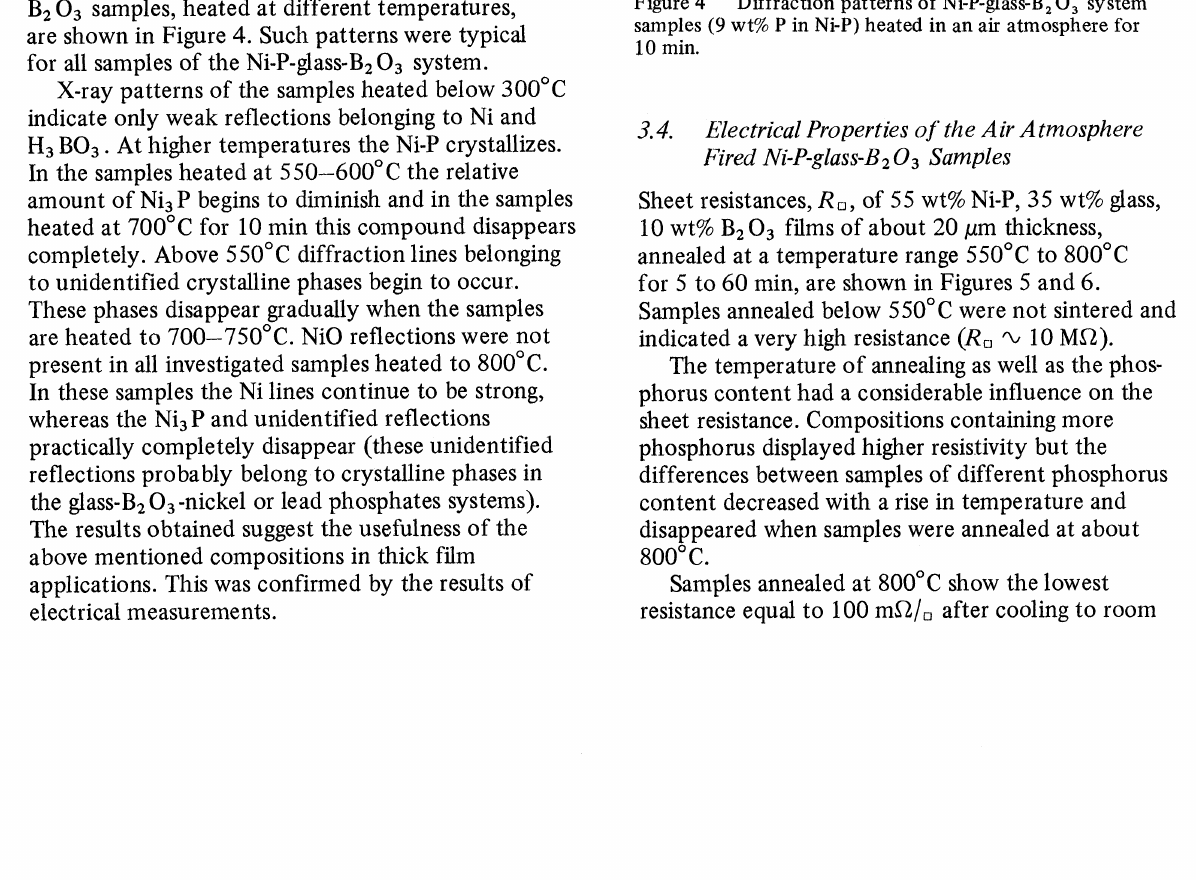
Figure 4 Diffraction patterns of Ni-P-glass-B Os system samples (9 wt% P in Ni-P) heated in an air atmosphere for 10